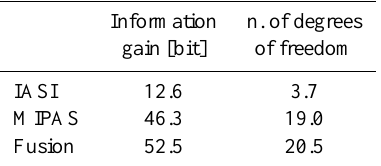
Table 3. Information gain and number of degrees of freedom for the profiles retrieved from real measurements using only the IASI measurement, only the MIPAS measurement and the IASI-MIPAS data